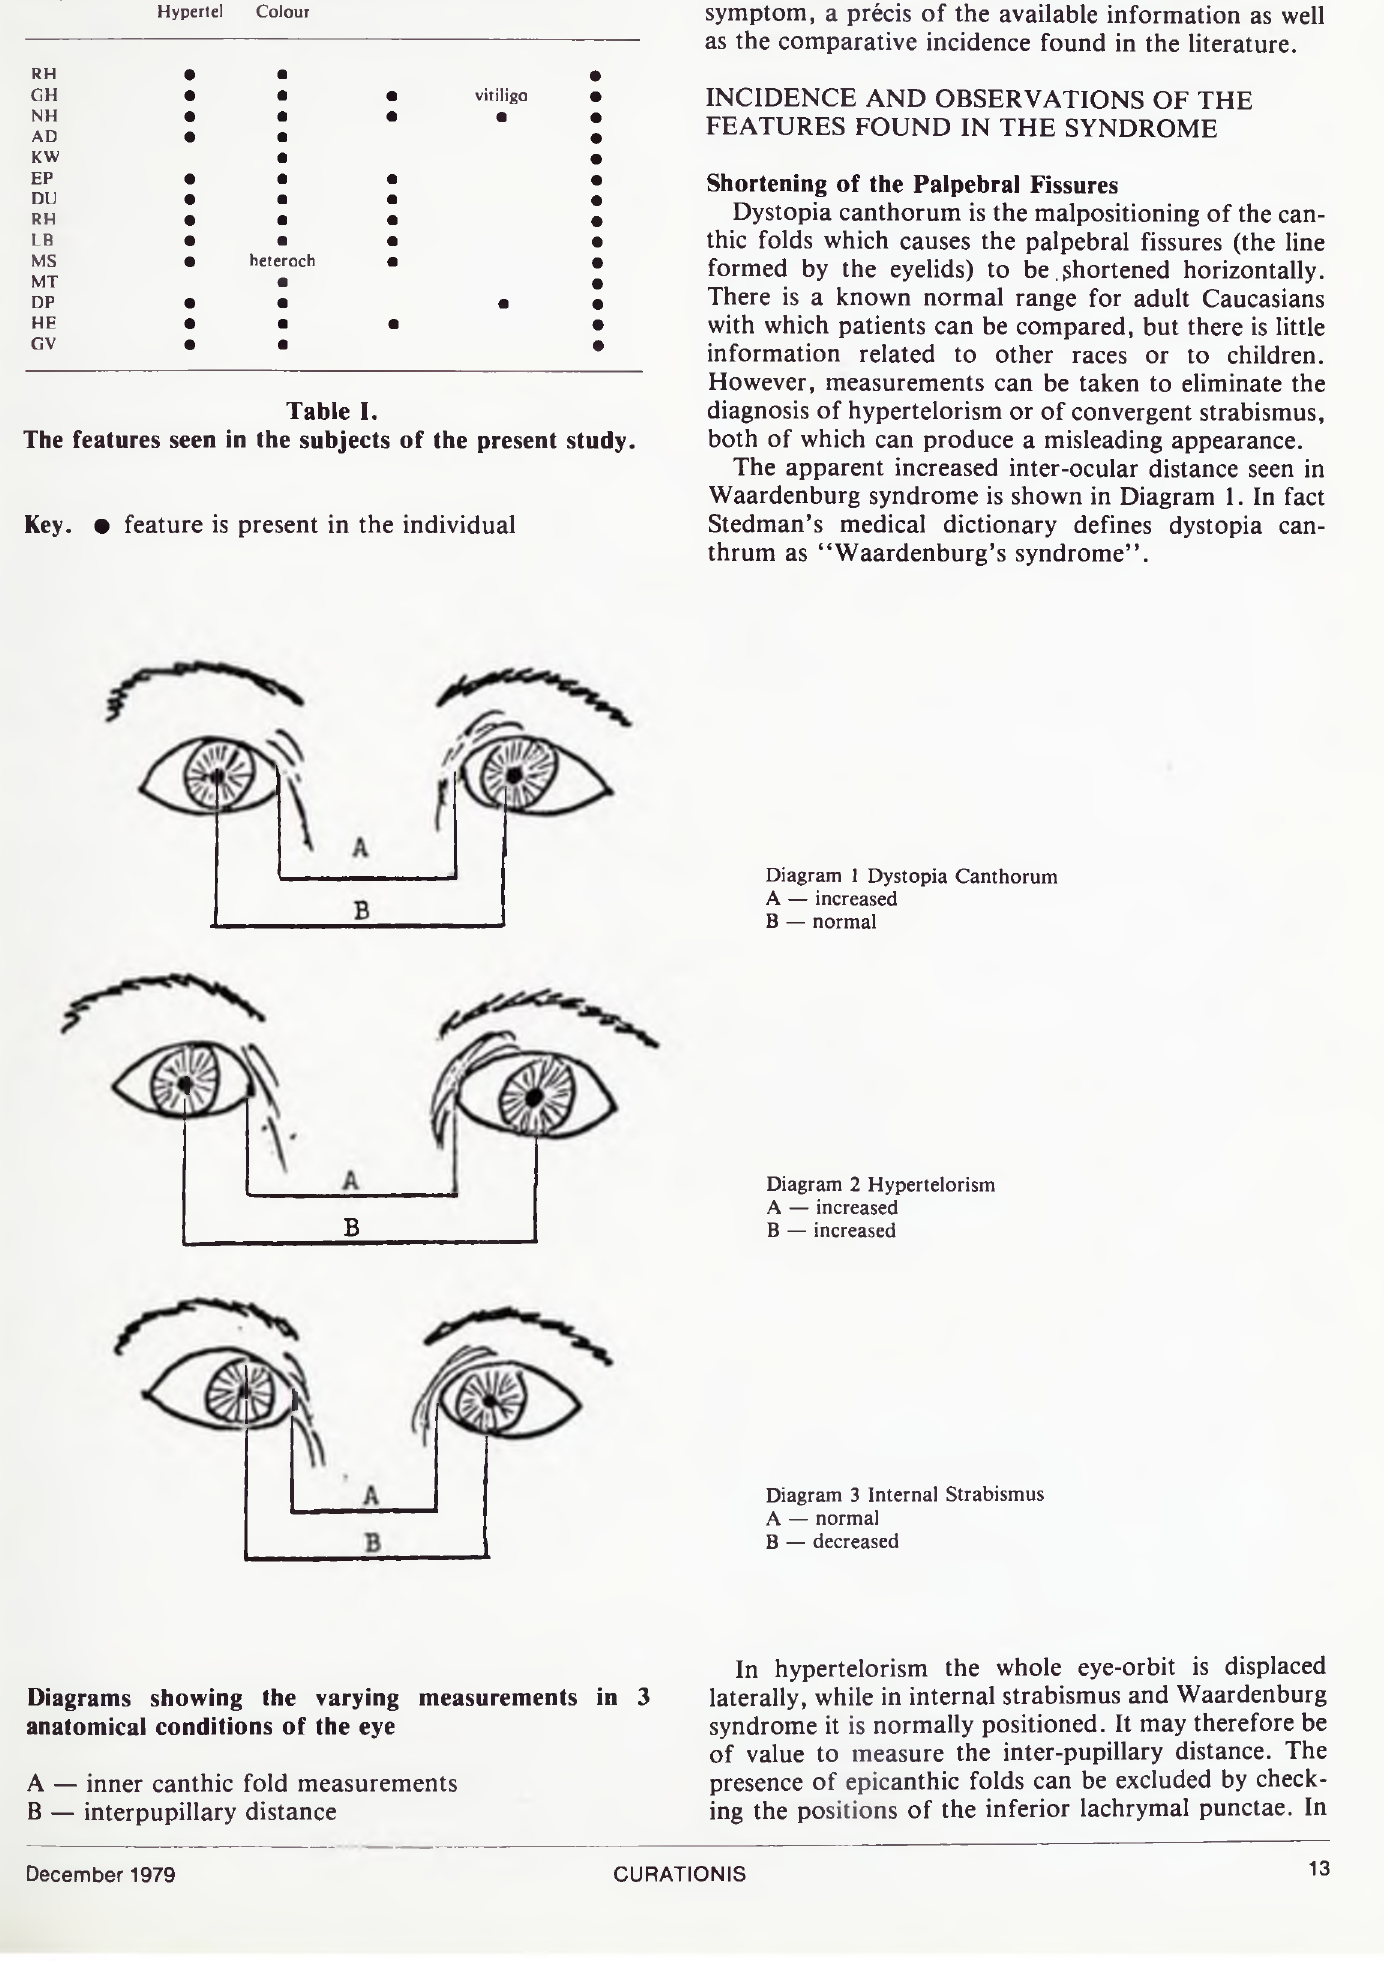
The features seen in the subjects of the present study.